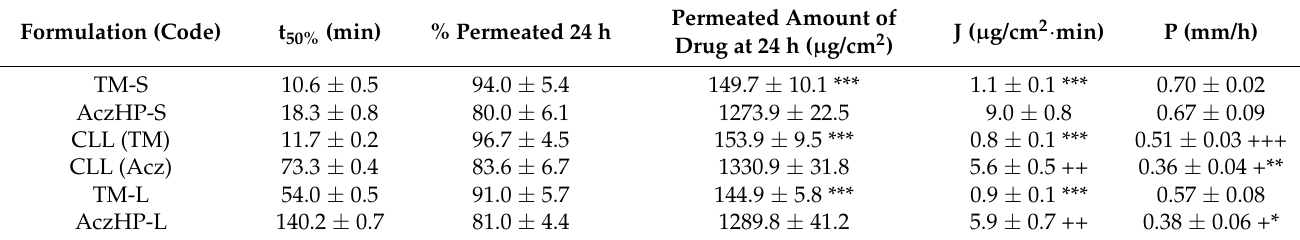
Figure 7. In vitro release profiles of ( a ) Acz from the co-loaded liposome formulation (CLL), Acz/HP β CD liposomes (AczHP-L), and Acz standard solution (AczHP-S); ( b ) TM from the co-loaded liposome formulation (CLL), TM liposomes (TM-L), and TM standard solution (TM-S). Table 7. Release and permeation parameters. J: flux rate; P: permeability coefficient. *** p < 0.001; ** p < 0.01 and * p < 0.05 (comparing between the same formulations); + p < 0.05; ++ p < 0.01 and +++ p < 0.001 (comparing liposomal formulations with the standard solutions).